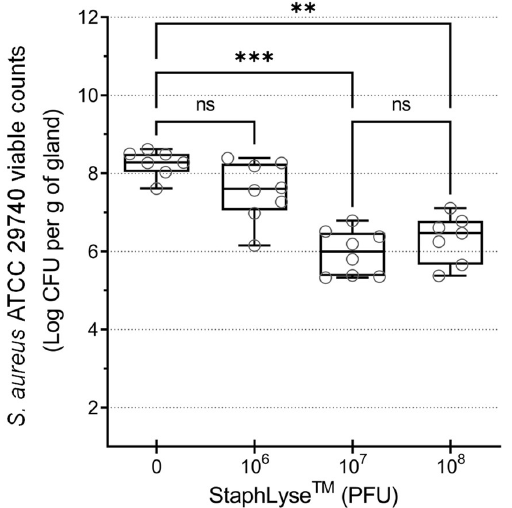
Figure 6. Dose-finding experiment in the mouse mastitis model of S. aureus infection. S. aureus ATCC 29740 was inoculated IMAM, at a dose of 100 CFU in a volume of 100 µL, in the 2 fourth glands in lactating CD-1 mice separated from pups 1 h prior to infection. Different doses of StaphLyse™ (in a volume of 100 µL) were administered as a single IMAM dose 4 h after infection. Mammary glands were harvested 18 h after infection, and bacterial loads into the glands were determined (CFU per gram of gland). Each group included 4 mice, with each mouse providing up to 2 glands. Each dot on the graph represents the bacterial load for each gland. The horizontal bars within the boxes indicate the median value for each group. The whiskers show the minimum and maximum values. The results were compared with the results of the placebo control group, which received PBS. Statistical